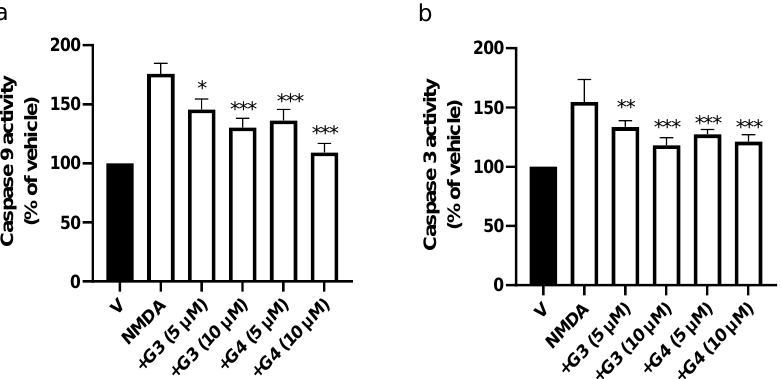
Figure 4. Effect of G3 and G4 phosphorous dendrimers on NMDA-induced ( a ) caspase 9 and ( b ) caspase 3 activities. Neurons were treated with vehicle (V) or the indicated concentration of G3 or G4 phosphorous dendrimers. Then, NMDA (150 µM) was added and incubation continued for 3 h. Caspase activity was determined in total lysates as described in the Materials and Methods section. The data are expressed as the mean + the s.e.m. of three independent experiments. * p < 0.05, ** p < 0.01, and *** p < 0.001 as compared to NMDA-treated cells in the absence of dendrimers.